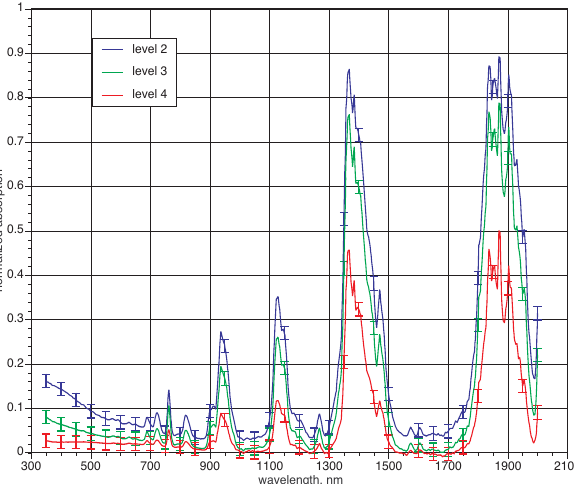
Fig. 5. Fractional absorption at three different altitudes for 6 March 2006. The altitude of the top level is 3367m above the